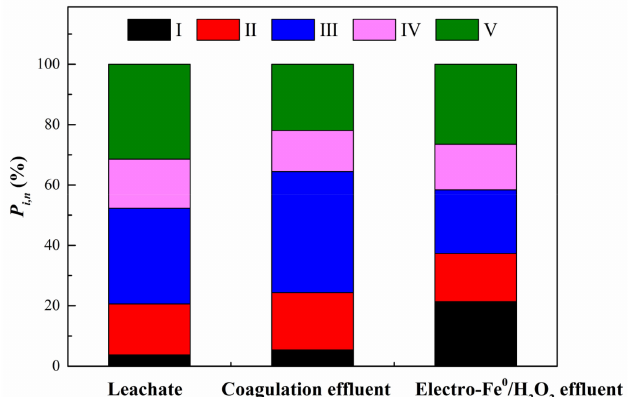
Figure 8. The P i,n values for the DOM of leachate, coagulated effluent, and electro-Fe 0 /H 2 O 2